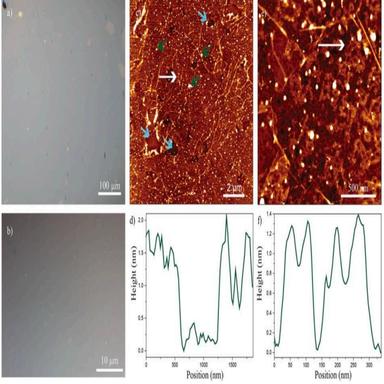
Optical micrographs a) and b) showing complete transfer of the MoS2/graphene sample from Ir(111) to the wafer substrate. c) AFM image of transferred MoS2/graphene sample with graphene wrinkles still present, tears in graphene sheet are highlighted with cyan arrows and residual PMMA with green arrows. d) Height profile along the white arrow on c) showing the thickness of transferred graphene. e) Larger magnification AFM image of transferred MoS2/graphene structure with distinguishable MoS2 islands. f) Height